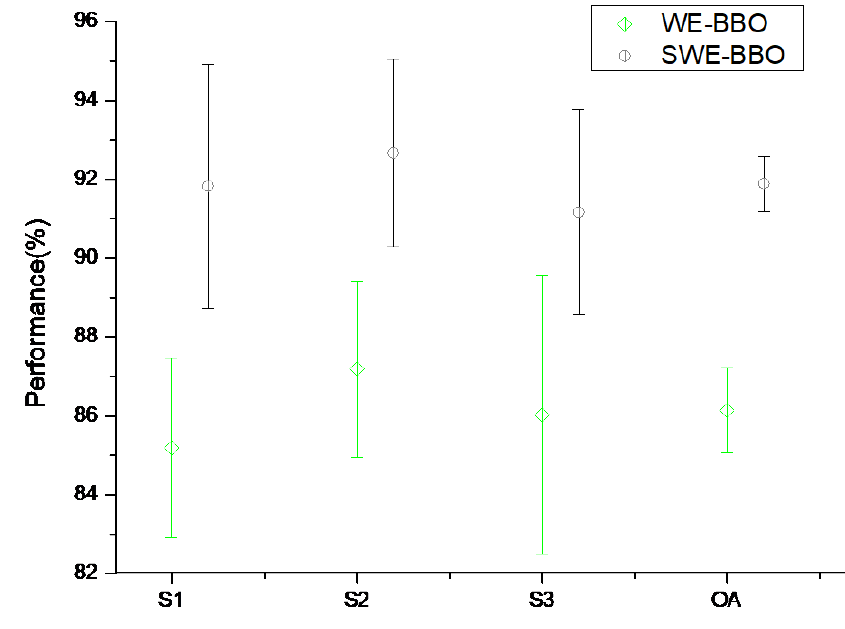
Figure 8. Error bar of WE-BBO and SWE-BBO.